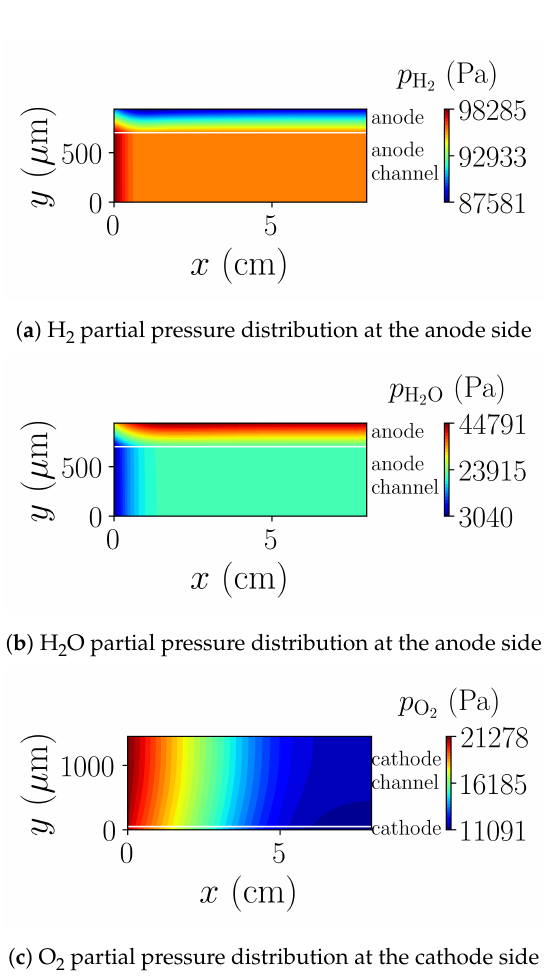
Figure 13. Partial pressure distribution inside the system (not in the